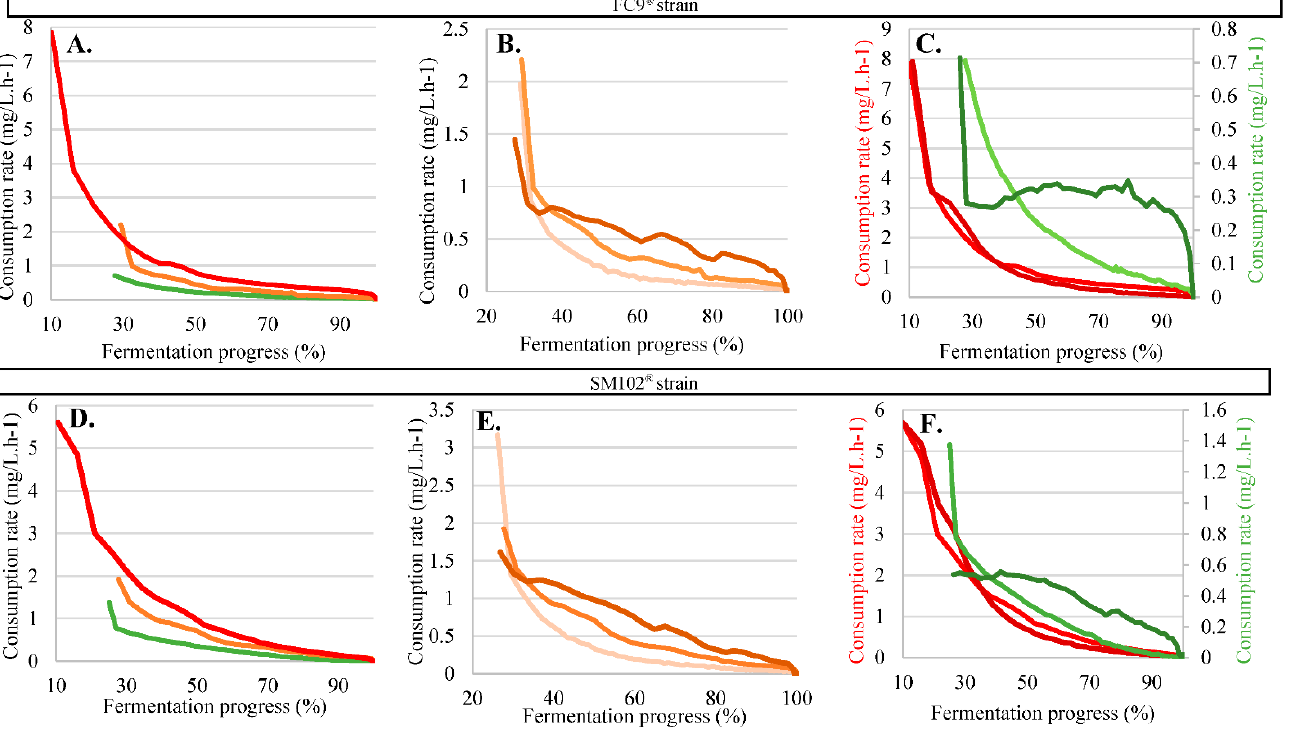
Figure 9. Acetaldehyde consumption rates (mg/L/h) for strains FC9 ® ( A - C ) and SM102 ® ( D - F ) with isothermal temperature profiles ( A , D ):18 °C (green), 24 °C (orange) and 30 °C (red)and anisothermal temperature profiles ( B , C , E , F ):24-18 °C (light orange), 24-30 °C (dark orange), 18-30 °C (dark green) and 30-18 °C (dark red). Table 2. Maximum acetaldehyde consumption rate at the beginning of the stationary phase. ANOVA statistical analysis: effects of temperature and strain.